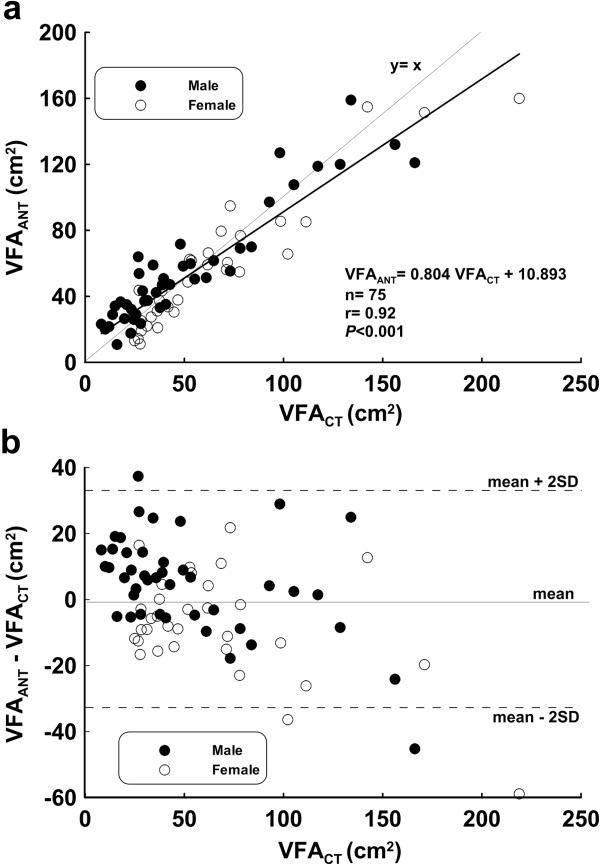
Validation group (a) Scatter chart and regression line (b) Bland-Altman Plot (mean: -0.37 cm
2
, mean – 2 SD: -33.44 cm
2
, mean + 2 SD: 32.70 cm
2
).